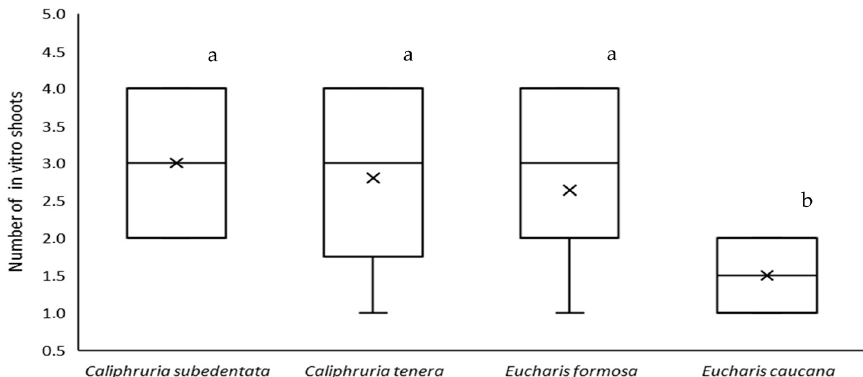
Figure 1. Effect of benzyladenine (BAP, 1.0 mg/L) and naphthaleneacetic acid (NAA, 0.2 mg/L) on the formation of in vitro shoots in C. subedentata , C. tenera , E. caucana , and E. formosa explants. Ac- cording to Tukey’s test, different letters indicate significant differences at the level of ( p ˂ 0.05).